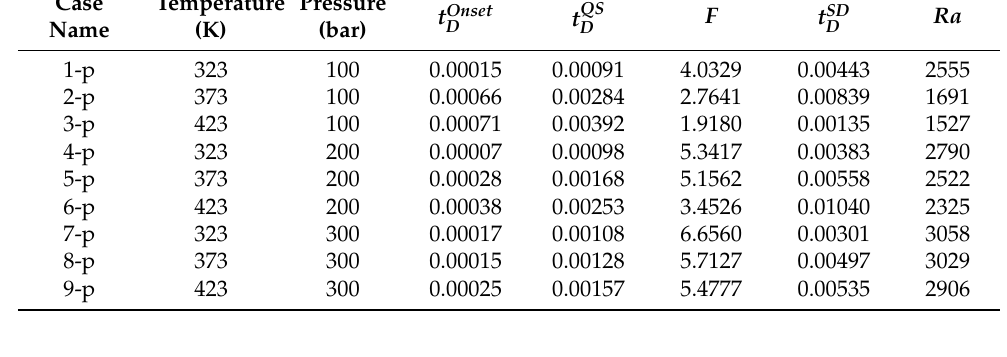
Figure 1. A schematic of different regimes in a dissolution process. Figure 2. The averaged dissolved CO 2 and dissolution flux for the pure case. Legends for left- and right-hand subplots are same. Table 3. Details of the pure cases.